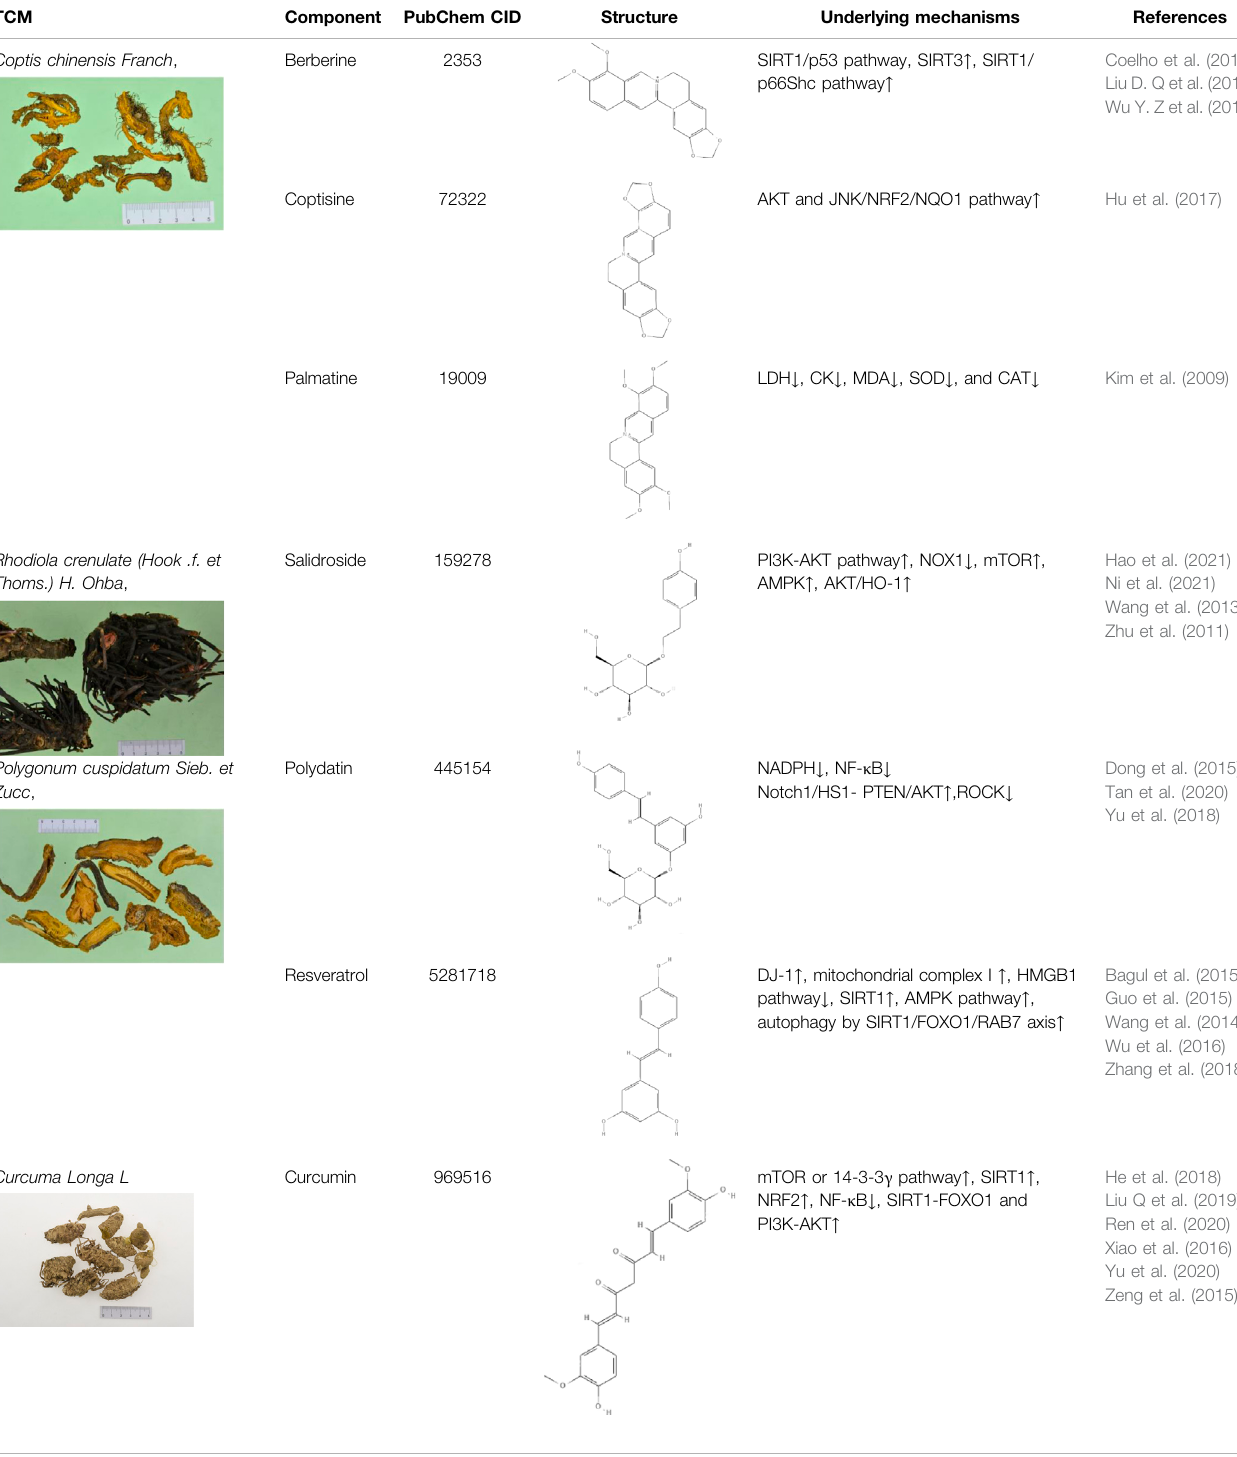
TABLE 4 | The mechanisms of TCM in improving oxidative